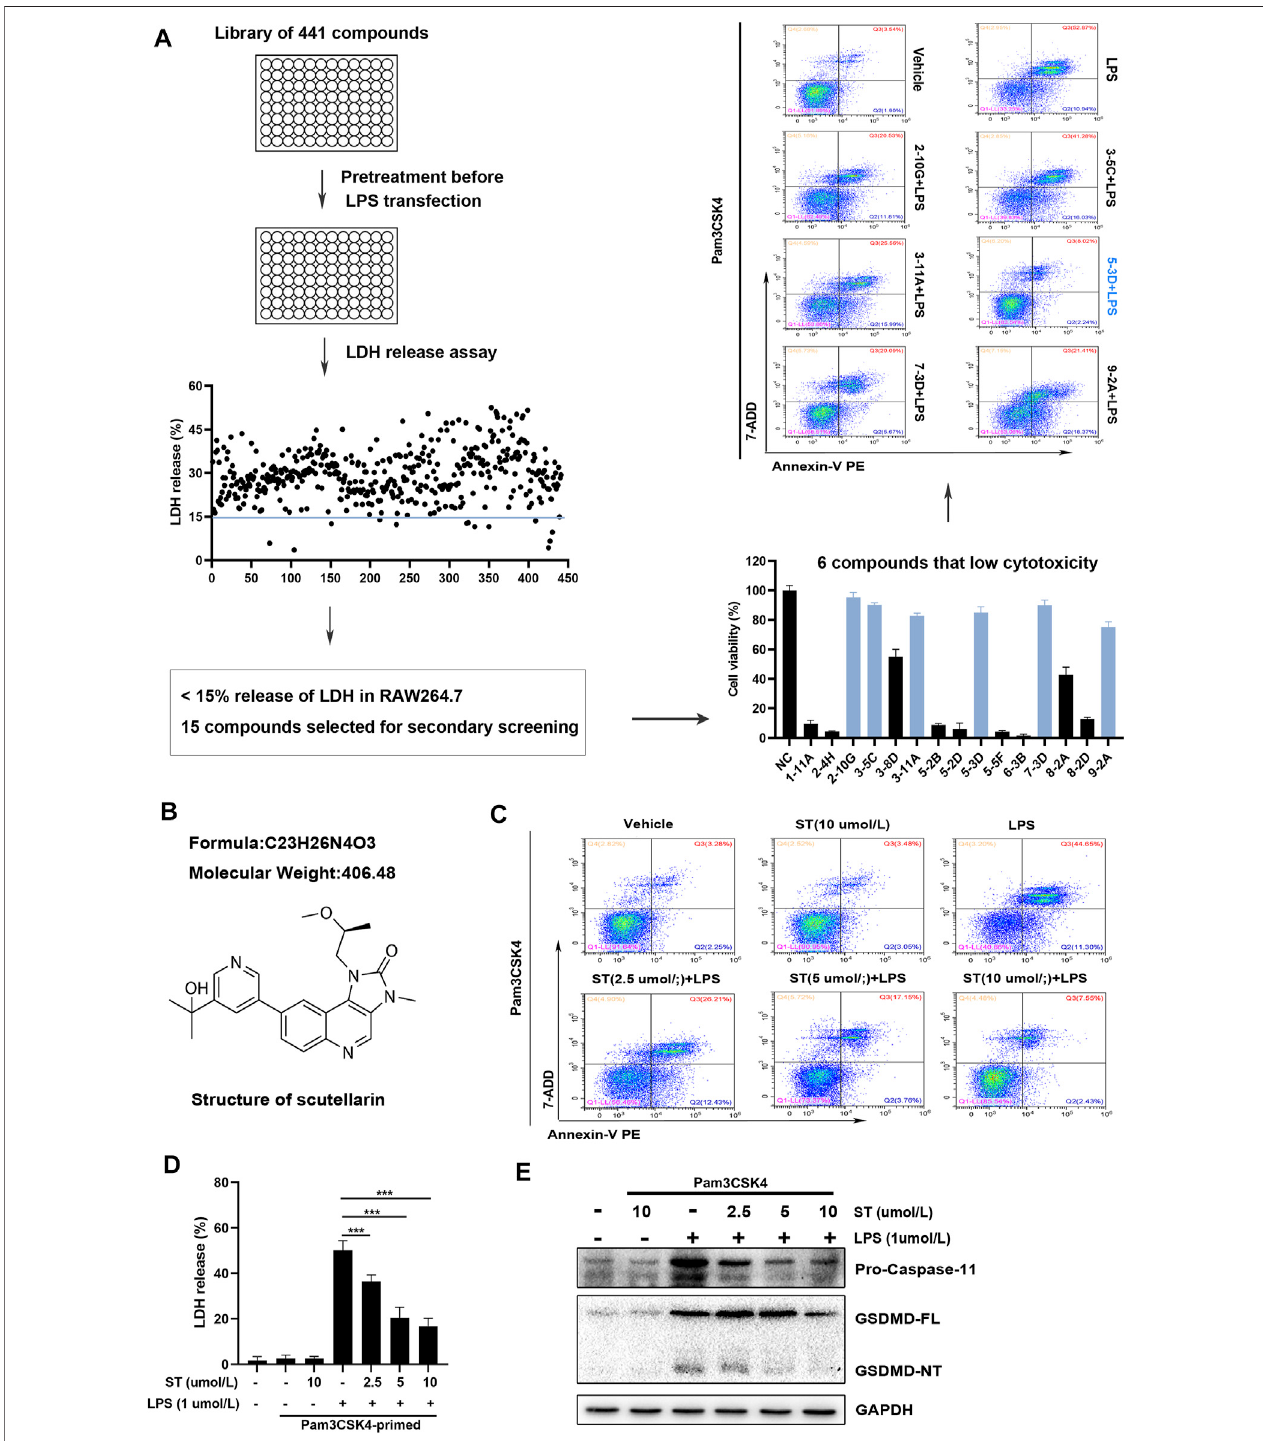
FIGURE 1 | Screening for compounds with the ability to inhibit caspase-11 activation and lytic cell death in RAW264.7 cells. (A) Flow chart for primary/secondary screeningandidenti fi cationofcompounds. (B) Chemicalstructureofsamotolisib. (C) PercentageofAnnexinVPEand7-AADdouble-positiveRAW264.7cellsdetected using fl owcytometry. (D) PercentageofLDHreleaseintheculturesupernatants. (E) Westernblotassayshowingthelevelsofcaspase-11andGSDMD-NTincelllysates. Glyceraldehyde 3-phosphate dehydrogenase (GAPDH) was adopted as a loading control.